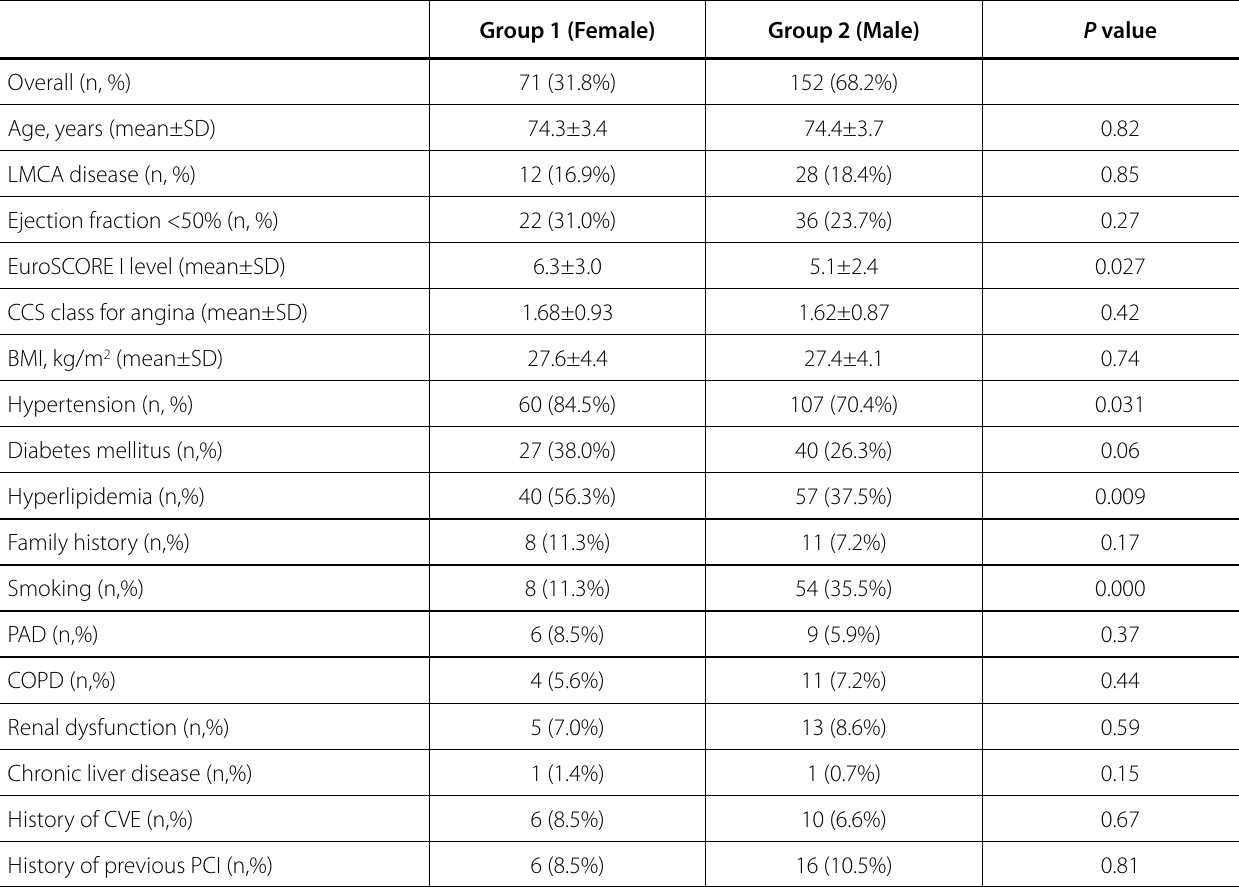
Table 1. Demographic and baseline clinical characteristics of the groups.